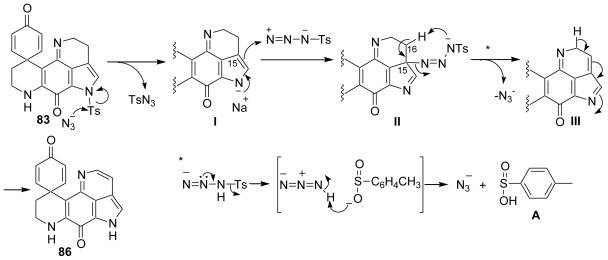
A plausible mechanism for the dehydrogenation reaction of pyrroloiminoquinone using NaN3.